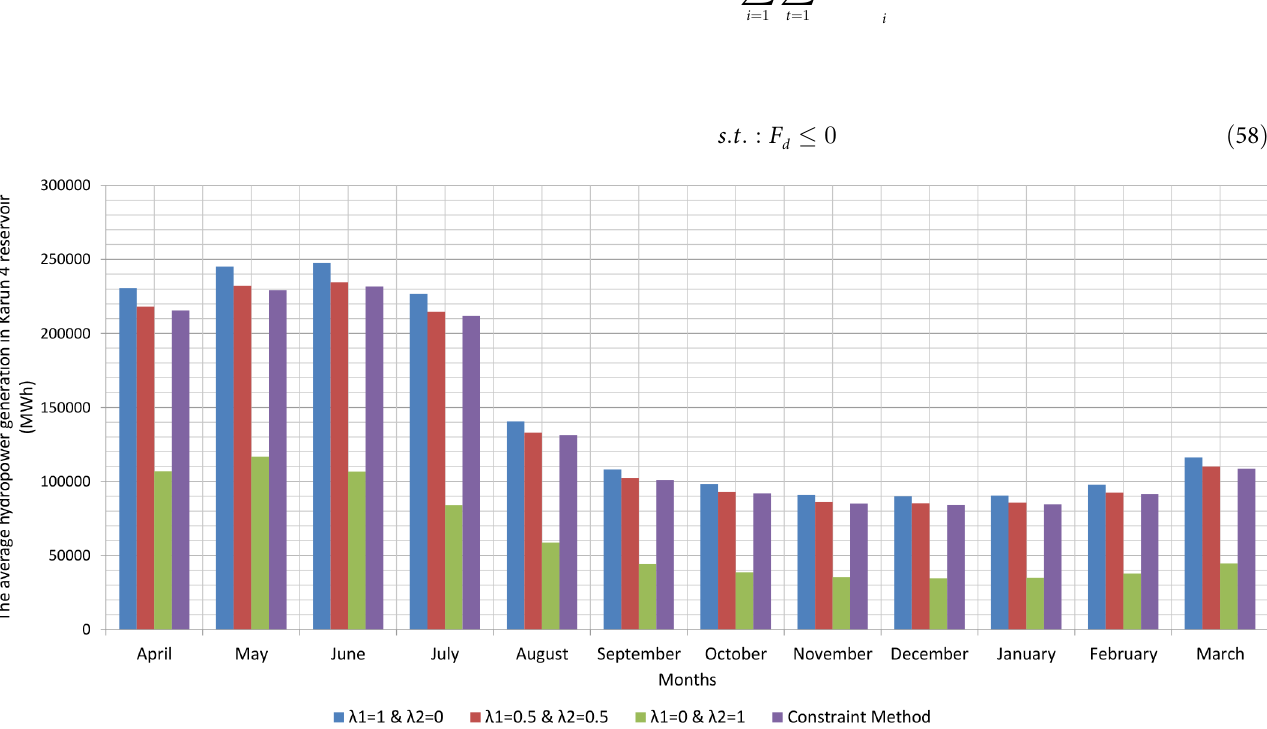
Fig 7. The average hydropower generation in Karun 4 reservoir